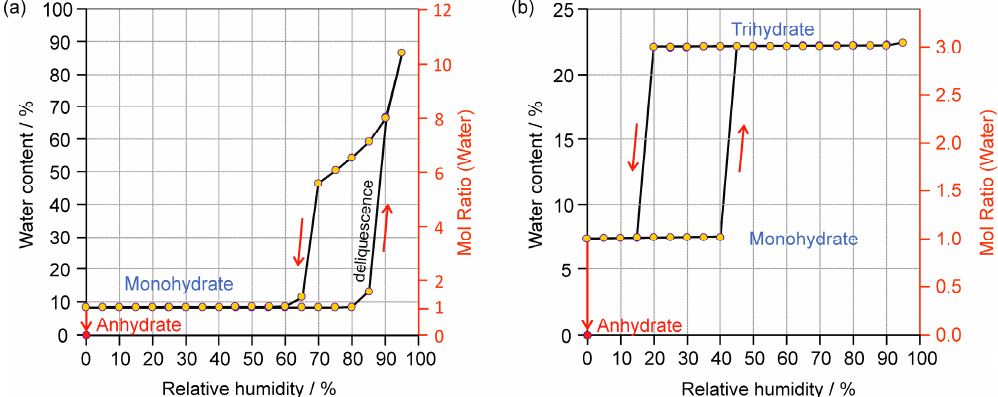
Figure 6. Gravimetric moisture sorption/desorption isotherms of ( a ) 1 and ( b ) 2 . Arrows indicate the course of the experiments. The anhydrates of the two compounds were obtained by storing the samples over P 2 O 5 .